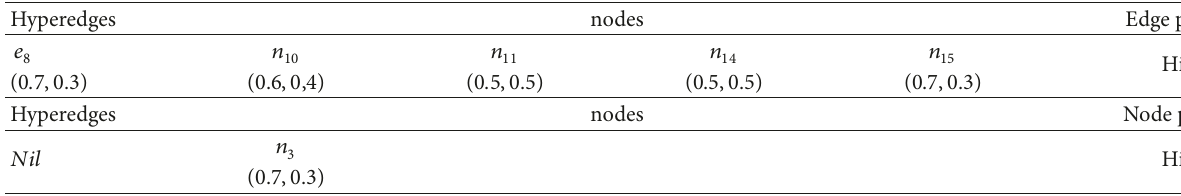
Table 2: Details of hypergraph 𝑋 𝐼𝐹 .